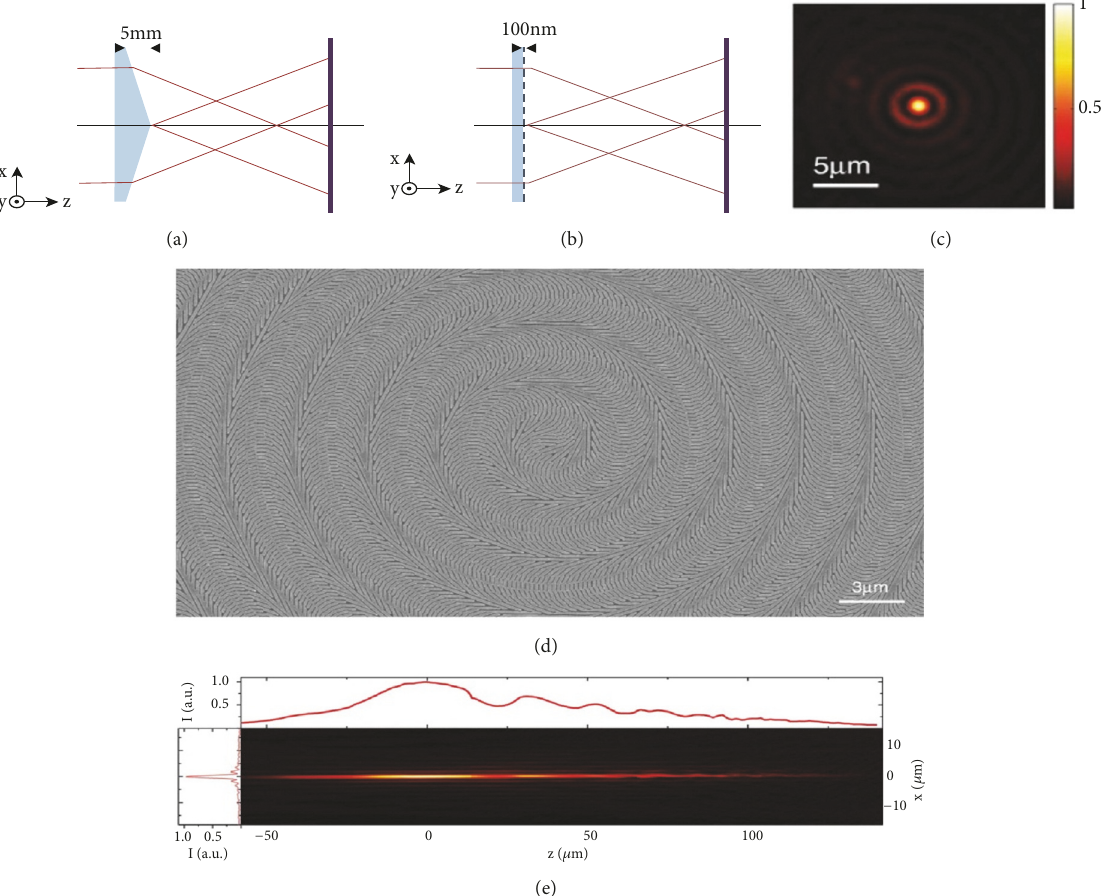
Figure 13: Example of a DGMOE: An axicon constructed from Si nanoantennas. (a) Schematic of a conventional glass axicon focusing light into a Bessel beam. (b) Schematic of a DGMOE axicon featuring an ultrathin patterned layer of silicon on a quartz substrate. (c) Transversal distribution of Bessel beam generated by the DGMOE. (d) SEM image of the fabricated DGMOE. (e) Measured intensity profile of the non- diffractive Bessel beam generated behind the DGMOE in the x and z plane. The intensity (I) along the center of Bessel beam is plotted in the inset along the z axis. The inset along the x axis shows the cross-sectional intensity profile at the z = 0 plane. a.u., arbitrary units [25].